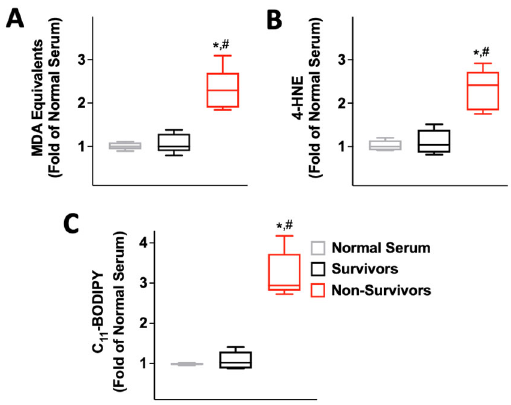
Figure 3. Lipid peroxidation in HUVECs is increased by serum from patients who did not survive COVID-19. Three different assays, namely the quantification of MDA equivalents ( A ), 4HNE ( B ), and C 11 -BODIPY ( C ), confirmed that the incubation of HUVECs for 24 h with serum from COVID-19 patients who did not survive significantly increased lipid peroxidation. All experiments were performed in triplicate; the box-and-whiskers graphs show the median and the 5 th –95 th percentiles; *: p < 0.01 vs. Normal Serum, #: p < 0.01 vs. Survivors.